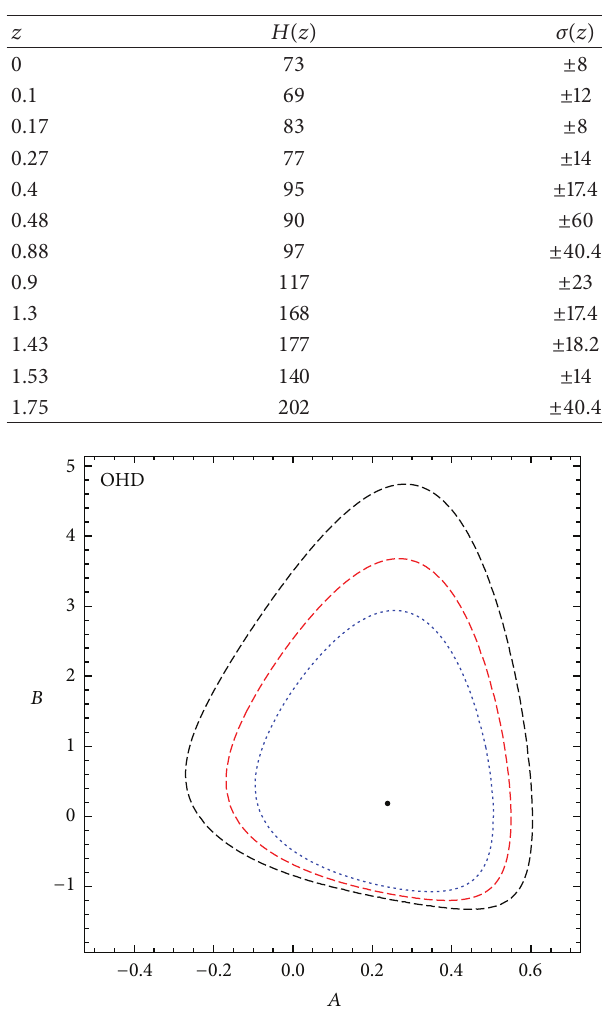
Table 1: The observed Hubble parameter 𝐻(𝑧) and the standard error 𝜎(𝑧) for different values of redshift 𝑧 .